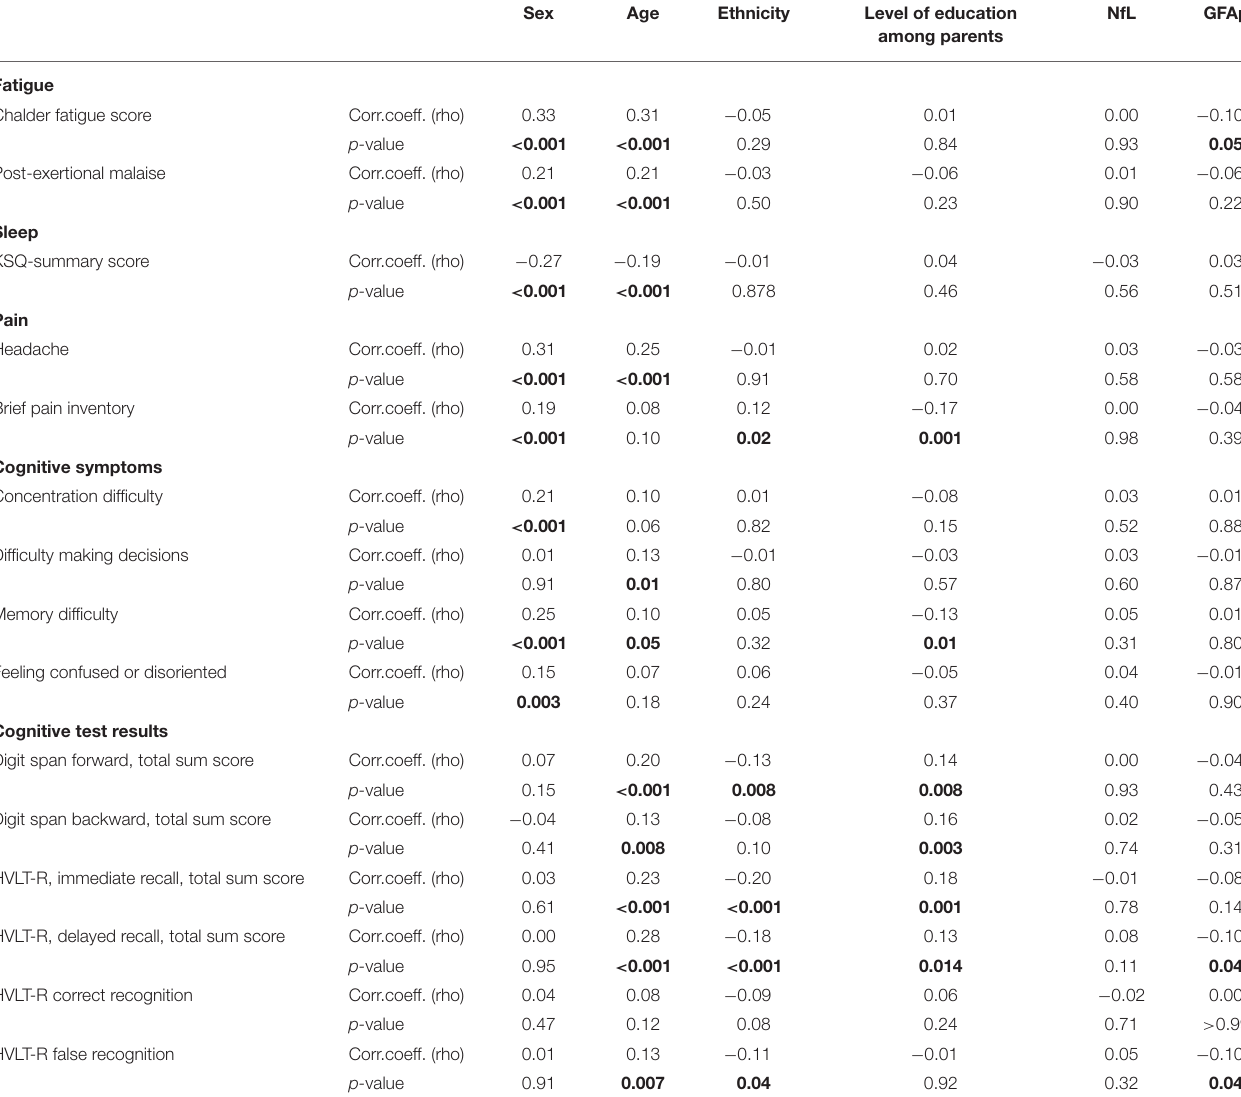
TABLE 3 | Correlation (Spearman’s rho) between background variables, symptoms, brain injury markers, and cognitive test results within the COVID-19 group a .